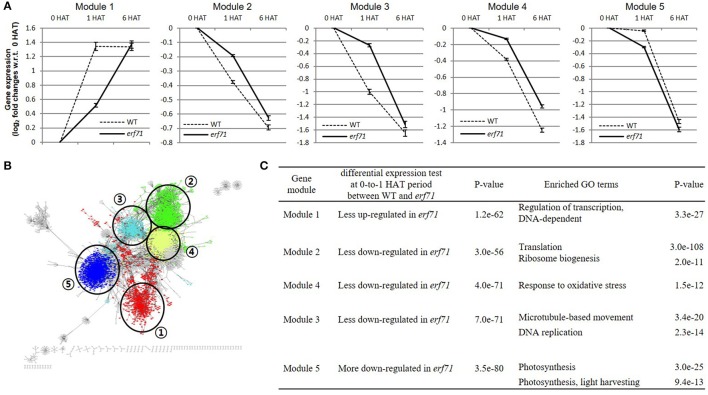
(A) Gene expression levels of the five differentially expressed modules. The y-axis shows the mean log2 fold change in gene expression level with respect to the 0 h after treatment (HAT) time point. Error bars are standard error of the means (SEMs). Module 1 was up-regulated in both types of rice but less so in erf71. Modules 2, 3, and 4 were down-regulated in both types of rice but less down-regulated in erf71. Module 5 was down-regulated in both types of rice but more down-regulated in erf71. (B) Module structures of the five modules with different colors in the dehydration network. Numbers in circles represents each module. (C) Results of the differential expression test and the gene ontology (GO) enrichment test of the five gene modules. The differential expression test of each module was performed using a t-test at 0-to-1 HAT between WT and erf71. The GO enrichment test was performed by Fisher's exact test. A p-value cutoff (p < 10−9) was used to decide differential expression and enriched GO terms.